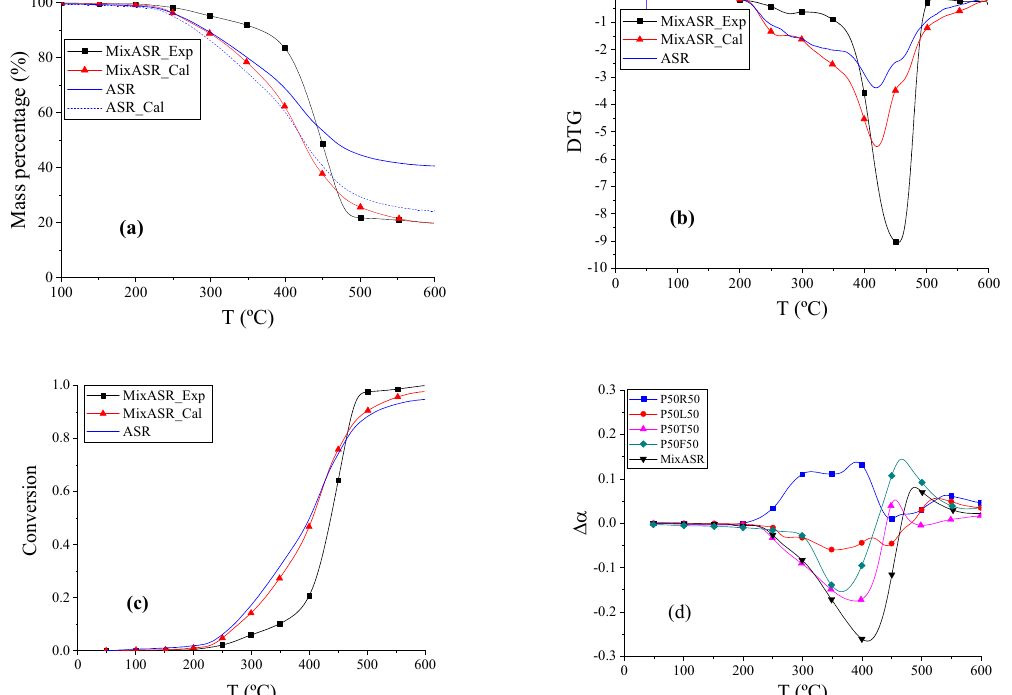
Figure 7. The TG, DTG, and conversion thermograms of MixASR and ASR and ∆α curves of the samples. ( a ) TG thermograms reflects the change in mass percentage during pyrolysis process. ( b ) DTG thermograms refer to the derivative curves of TG thermograms. ( c ) Pyrolysis conversion thermograms. ( d ) Conversion rate difference thermograms are subtracting the calculated value from the experimental value.